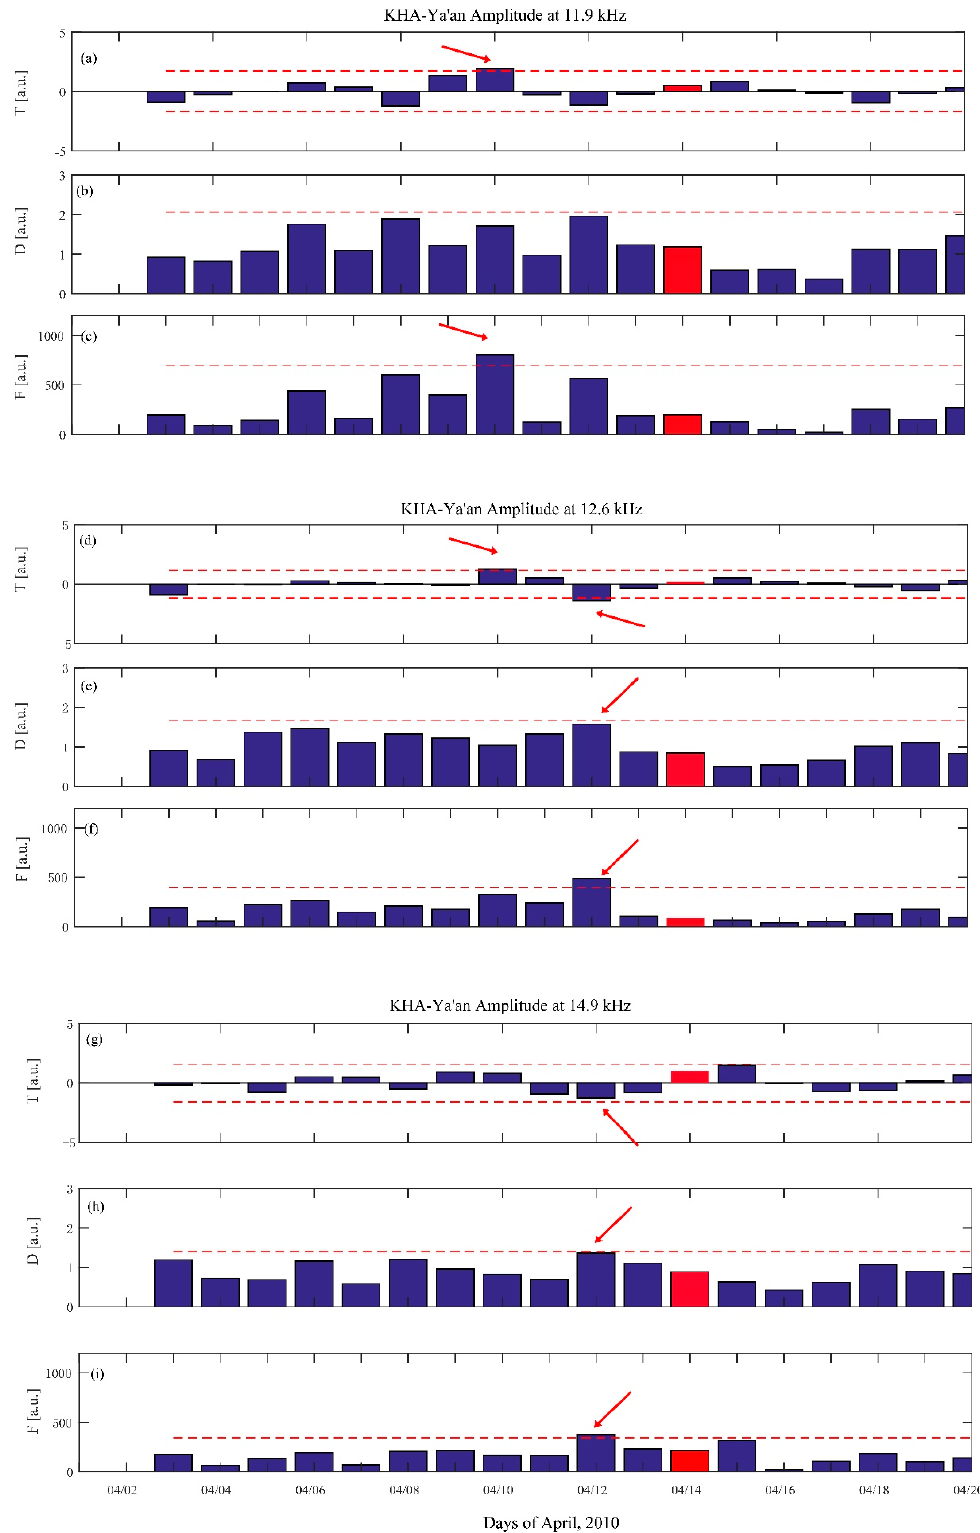
Figure 5. Nighttime fluctuation analysis of KHA-Ya’an at F1, F2, and F3 around the Yushu earthquake on 14 April 2010, shown in red. The trend (T) ( a , d , g ), dispersion (D) ( b , e , h ), and fluctuation (F) ( c , f , i ) of the three frequencies are shown separately. The horizontal line in each panel depicts the 2 σ deviation criterion to define the anomalous day; the red arrows mark the anomaly.